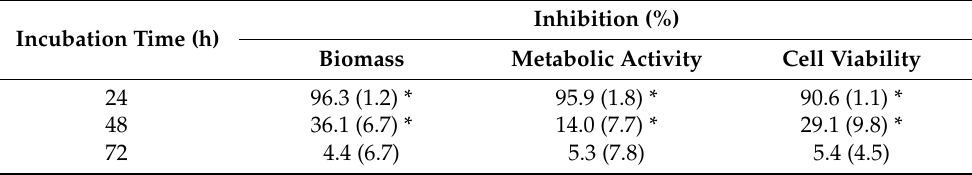
Table 1. Inhibition percentages of C. albicans-S. aureus multi-species biofilm determined by CV staining (biomass), MTT reduction assay (metabolic activity) and viable cell counting (cell viability), after 24, 48 and 72 h. Data are reported as mean and standard